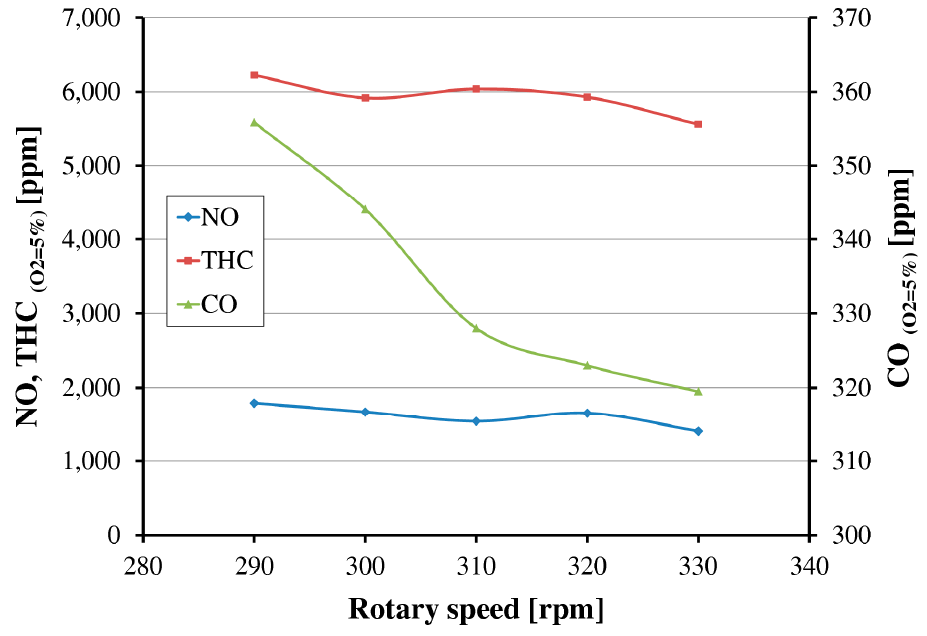
Figure 5. Overall emission for gas engine GMVH-12 with spark plugs ignition system.